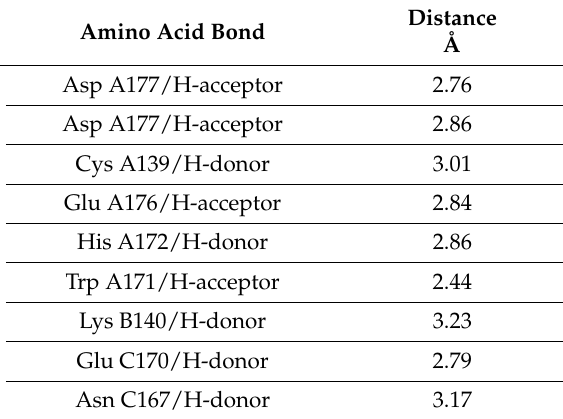
Table 2. Receptor interaction with identified glycyrrhizic acid ammonium salt and salicylic acid into the central binding site in the leaf roll viral protein